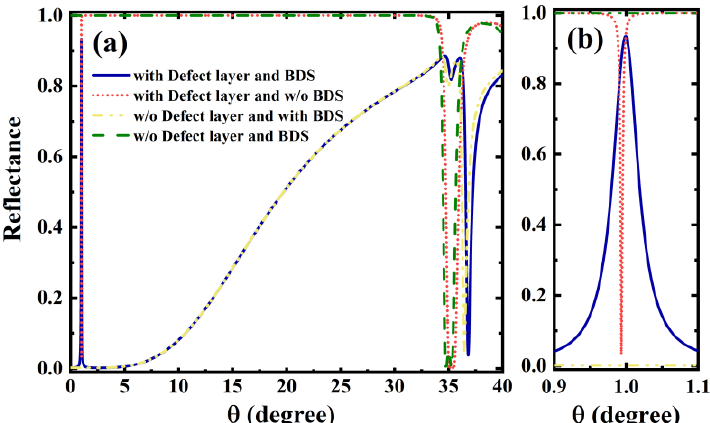
Figure 2. ( a ) For liquid biosensor parameters, the variation of reflectance with incident angle for four scenarios: loaded BDS and defect layer (blue solid line), loaded defect layer but no BDS layer (red short dotted line), loaded BDS but no defect layer (yellow double-dotted line), and no BDS and defect layer (green dashed line); ( b ) Local magnification of the reflectance curve.